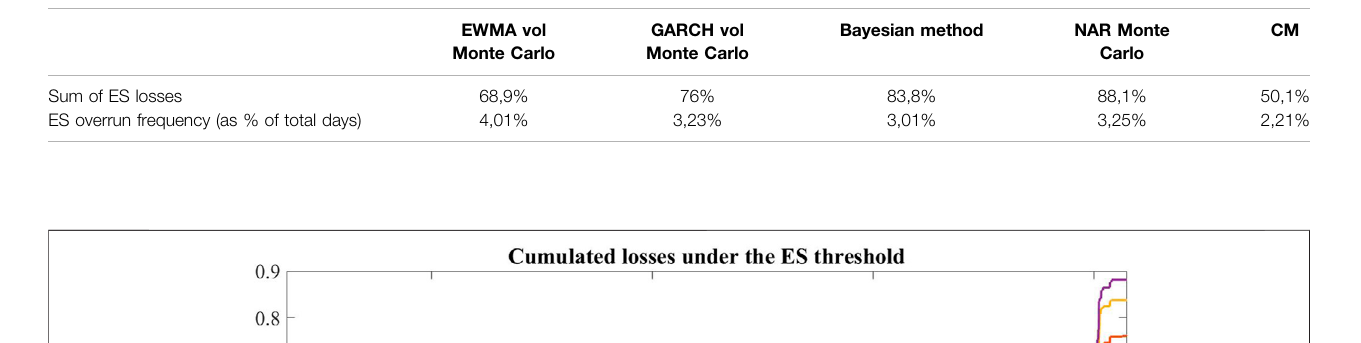
TABLE 4 | Overall value of loss function for the four ES methods and the CM.